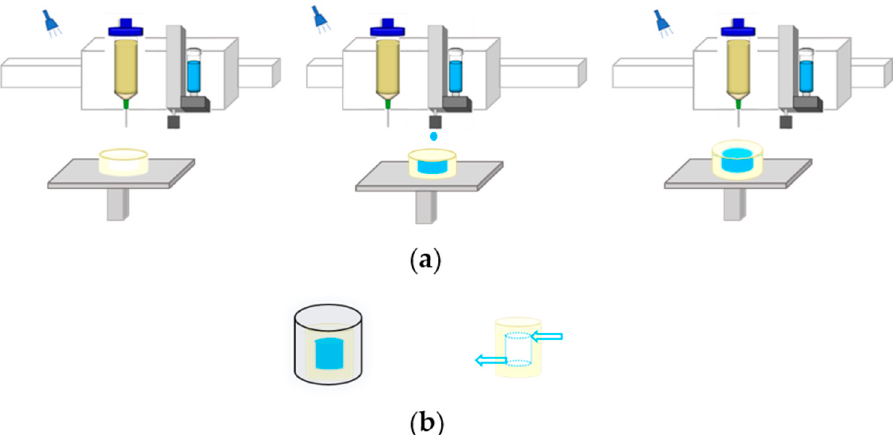
Figure 1. Schematic showing the process of fabricating the hydrogel matrix with embedded perfusable channels: ( a ) sequential printing of ejecting a sacrificial ink into photocurable hydrogel matrix by dual-head printer; ( b ) post-printing process including immersion in a CaCl 2 solution to crosslink and remove sacrificial ink to fabricate channels.